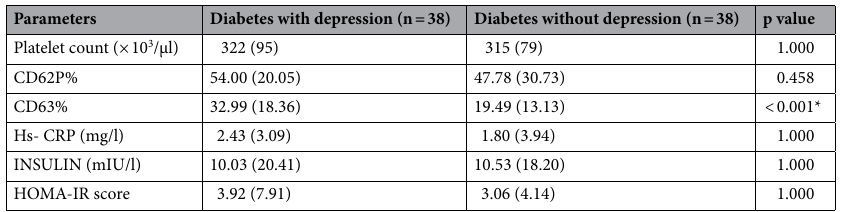
Table 3. Comparison of platelet parameters, hs-CRP, insulin and HOMA-IR score between participants of diabetes with depression and diabetes without depression. Results represented as Median (IQR). Data